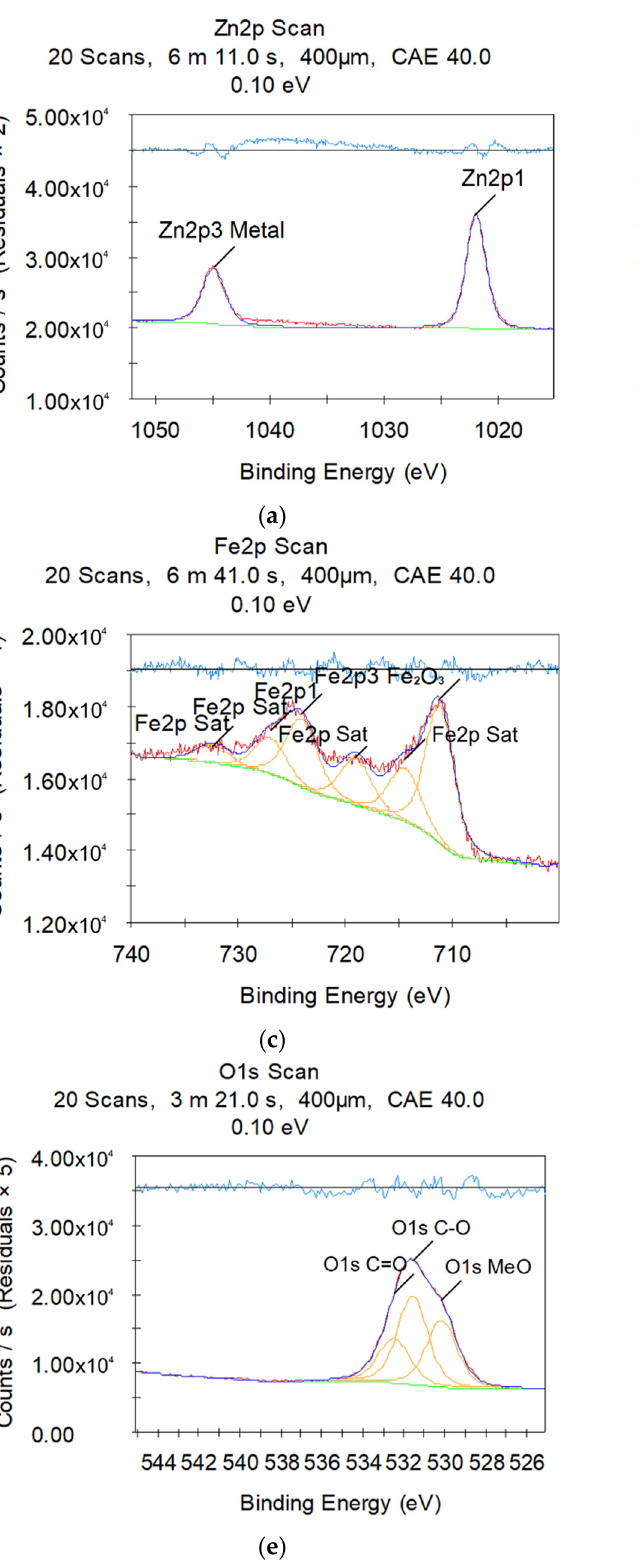
Figure 4. X-ray photoelectron spectroscopy of machined surfaces of X10CrNiTi18-10 (12kH18N10T) steel workpiece in water medium: ( a ) zinc; ( b ) copper; ( c ) iron; ( d ) chromium; ( e ) oxygen; ( f ) carbon.